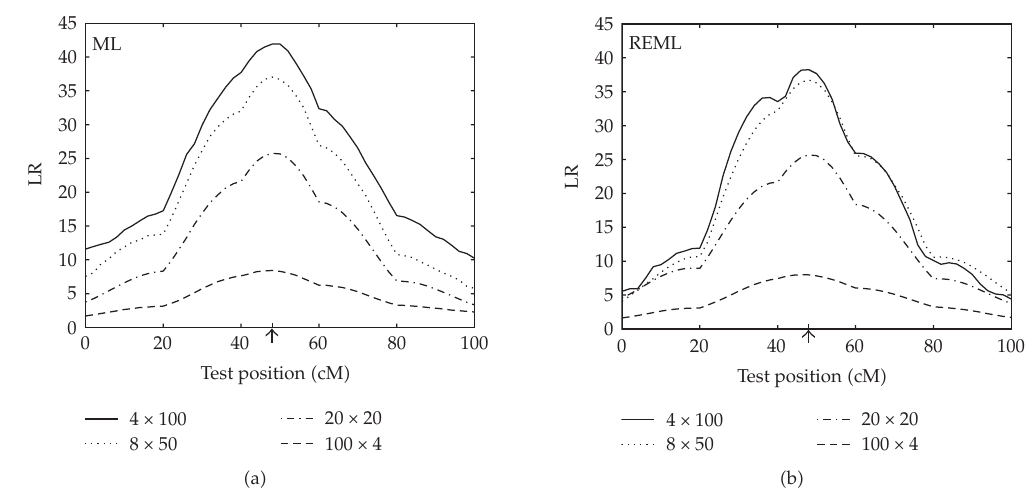
Figure 2: The LR profile plot. The left and right figures correspond to the LR profiles generated using the ML and REML methods, respectively. The arrow indicates the true QTL